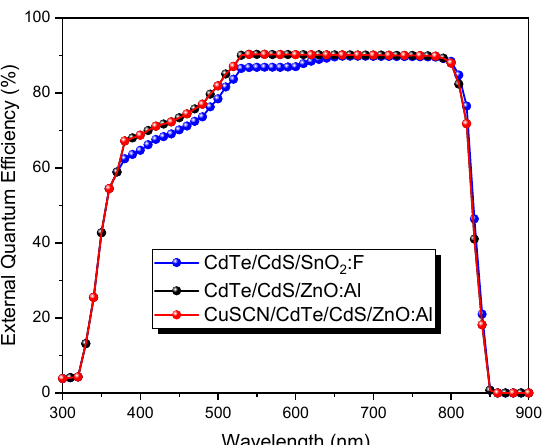
Figure 10. The external quantum efficiency of CdTe solar cells with different configurations.